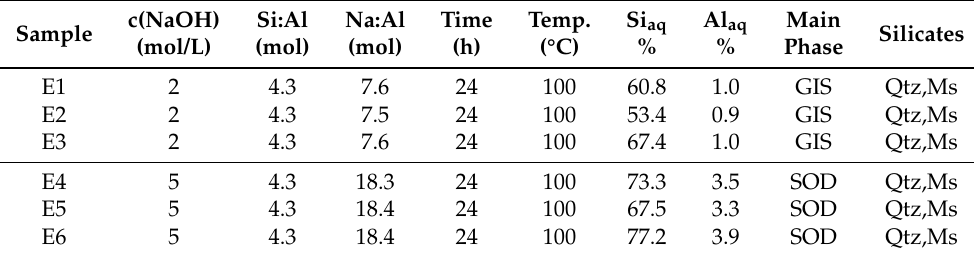
Table 3. Experimental conditions used for the hydrothermal synthesis of GIS- and SOD-zeolites from perlite powder (step 1). Si aq and Al aq denote the fractions of Si and Al remaining in the reacted solution at the end of the first extraction step. The mineralogical composition of the solids (product E) is indicated on the right. Quartz (Qtz) and muscovite (Ms) are impurities that are inherited from the perlite raw material.